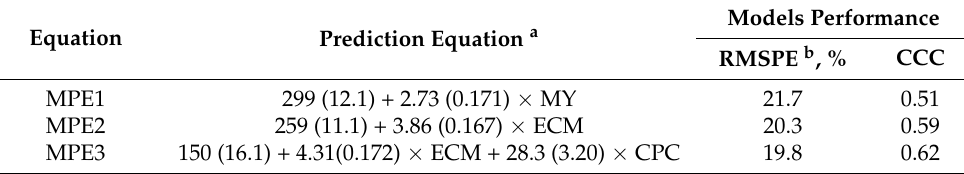
Table 2. Methane production (g/lactation per cow) equations